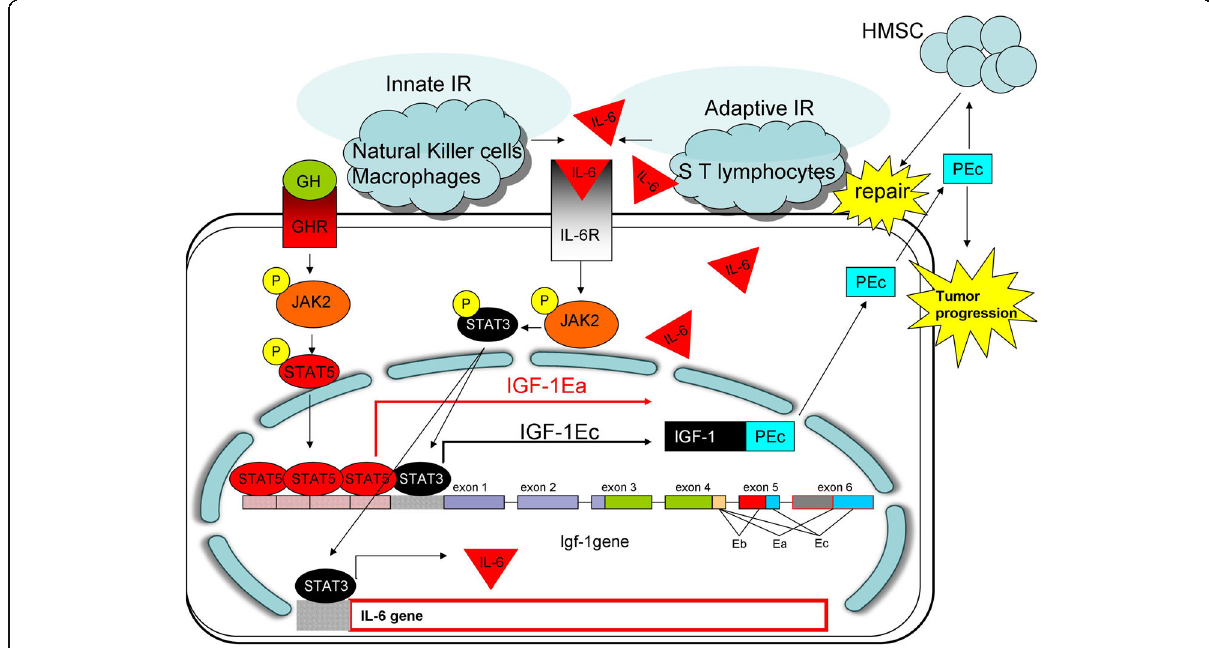
Fig. 5 The effect of the IR on the expression of the IGF-1Ec isoform. GH binding to GHR leads to IGF-1Ea upregulation through JAK2/STA5 path- way. In a similar manner, IL-6 is initially produced by the cells of the immune system attacking prostate tumor.. Binding of IL-6 on IL-6R leads to the upregulation of the IGF-1Ec isoform and to the secretion of PEc as well as to IL-6 secretion from prostate cancer cells, by activating the JAK2/ STAT3 pathway. PEc secretion leads to tumor progression and metastases acting in an autocrine and/or paracrine manner and it mobilizes MSC towards the tumor, prior to